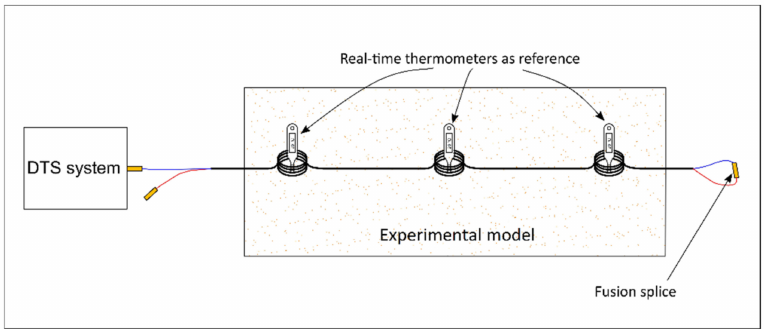
Figure 2. Installation of optical fiber and temperature sensors as references.